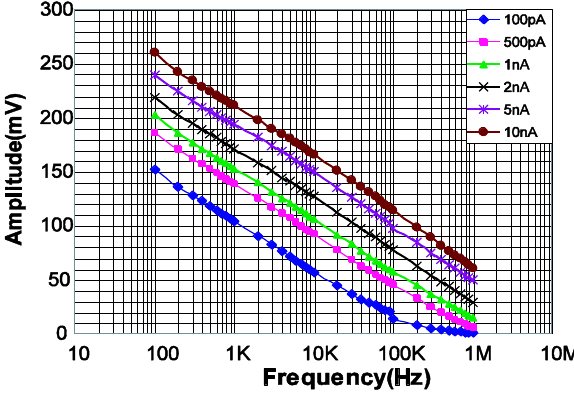
Figure 20. Amplitude as a function of Pulse Frequency (LED: λ = 870 nm, IE = 80 mW/sr, Lens: FN = 1.4, f = 6 mm, Distance: 2